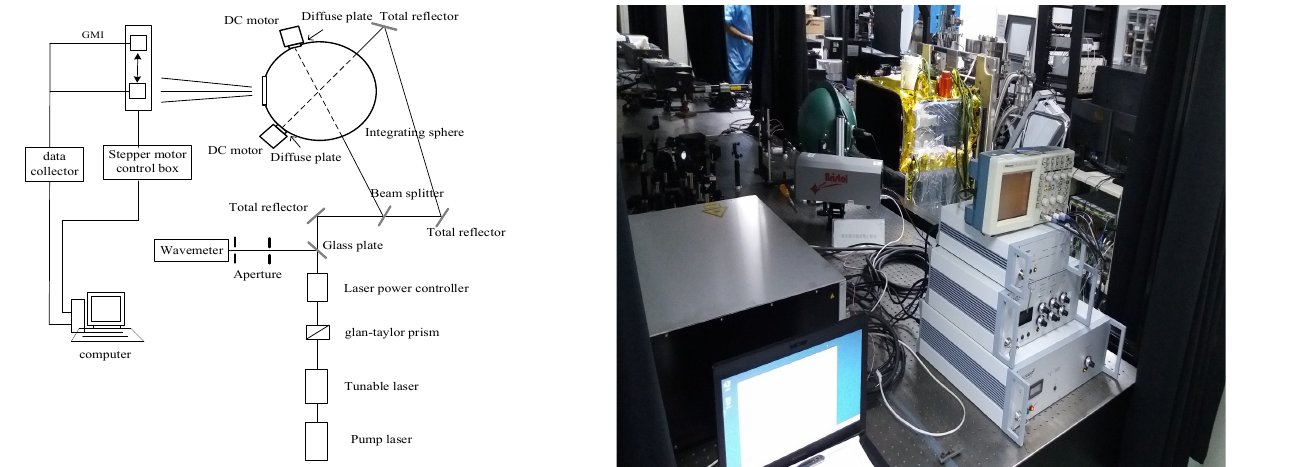
Figure 3. Layout of the tunable laser hyperspectral scanning spectral calibration and the spectral calibration experiment.